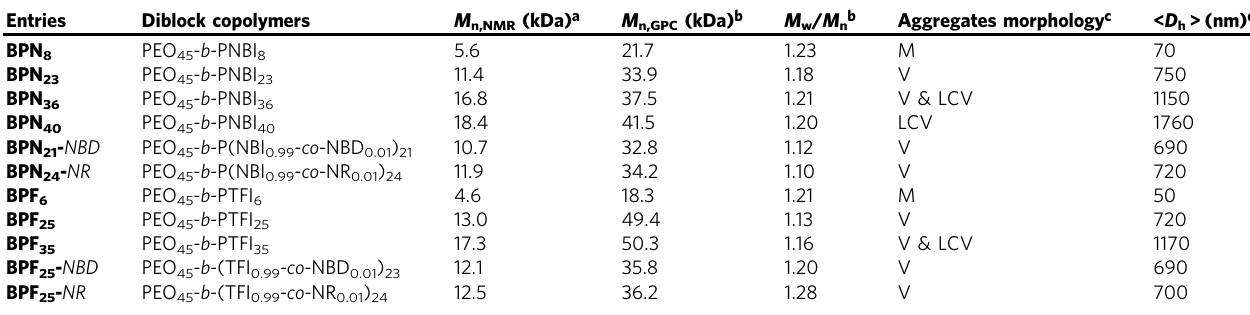
a Determined by 1 H NMR analysis. b Number-average molecular weights, M n , and molecular weight distributions, M w / M n , determined by GPC using DMF as eluent (1.0mL/min). c Determined by TEM and SEM analysis (M = micelles, V = vesicles, LCV = large compound vesicles). d Determined by DLS